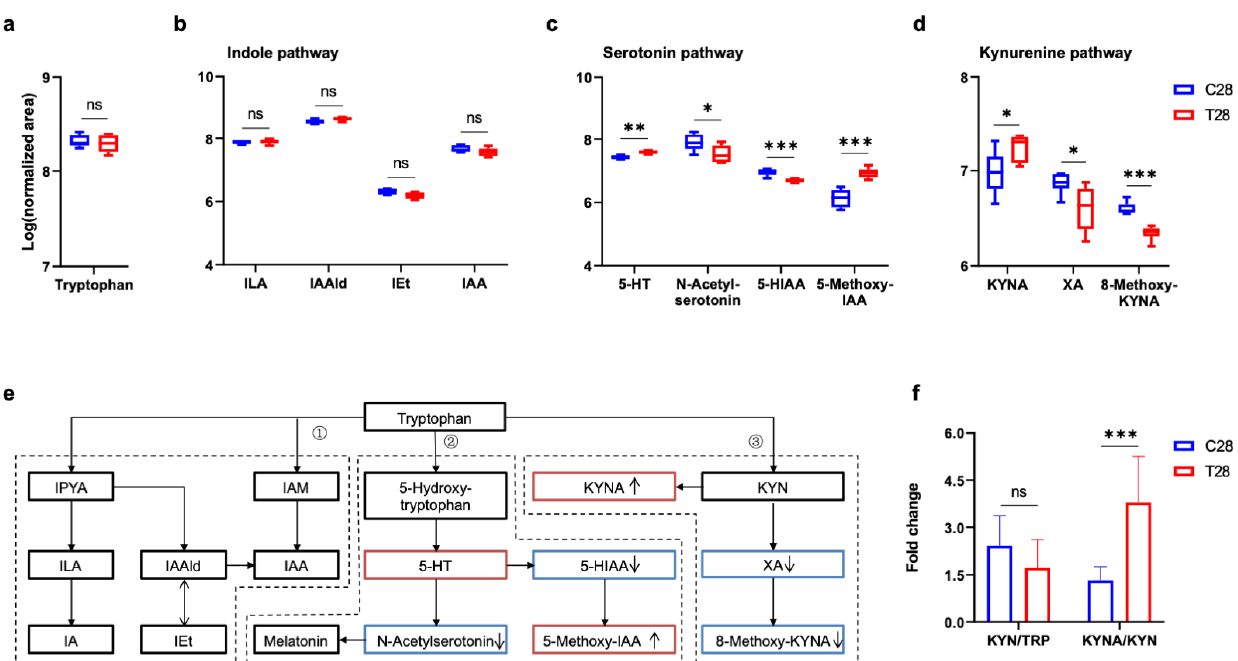
Figure 7. Alteration of serum tryptophan metabolic pathway at 28 days post-TBI. Comparison of serum tryptophan ( a ) and major tryptophan metabolites in indole pathway ( b ), serotonin pathway ( c ), and kynurenine pathway ( d ) at 28 days post-TBI. ( e ) Major tryptophan metabolism pathways are involved: (1) Indole pathway: Tryptophan can be directly metabolized by the gut microbiota into indole derivatives; (2) Serotonin pathway: Peripheral production of the neurotransmitter serotonin by enterochromaffin cells is influenced by the gut microbiota, and the brain can also synthesize serotonin; (3) Kynurenine pathway: Kynurenine-producing pathway plays a critical role in immune response and neurobiological functions, which is also affected by gut microbiota. ( f ) The ratios of KYN/TRP and KYNA/KYN at 28 days post-TBI. ↑ , increased; ↓ , decreased in 28 days post-TBI mice. The tryptophan and its metabolite listed in the pathways were marked with black (unchanged), red (increased), and blue (decreased) solid boxes. Data are shown as median with range. * p < 0.05, ** p < 0.01, *** p < 0.001 using unpaired Student’s t test. TBI, traumatic brain injury; TRP, tryptophan;